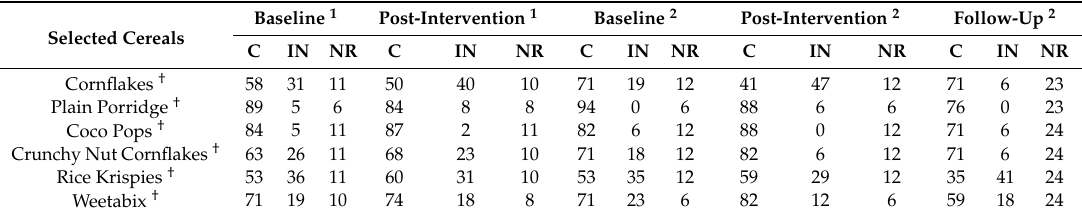
Table 4. Correct and incorrect responses to the sugar content of common breakfast cereals at baseline and post-intervention ( n = 62) and 3–4 months follow-up ( n = 17). Baseline 1 Post-Intervention 1 Baseline 2 Selected Cereals Cornflakes †